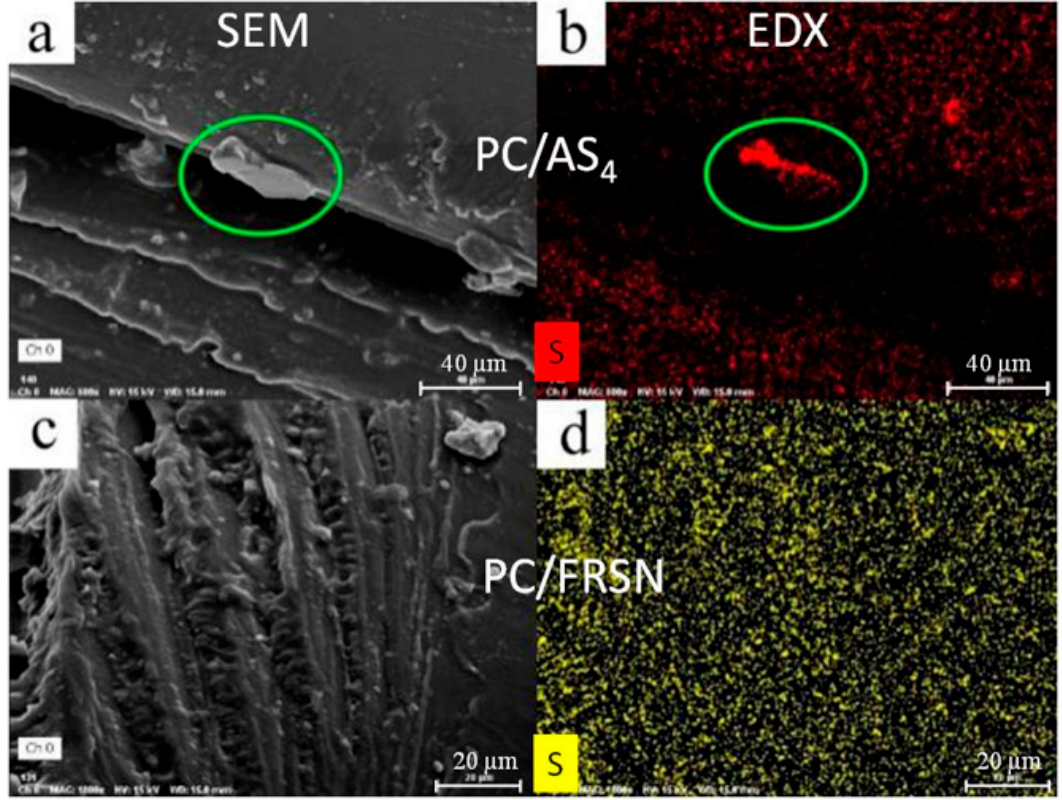
Figure 7. ( a , c ) SEM micrographs and ( b , d ) EDX mapping pictures of PC / AS 4 (0.08 wt%) and PC / FRSN (0.08 wt%), respectively. Sulfur element in EDX picture is marked in red and yellow for PC / AS 4 , and PC / FRSN composite, respectively.